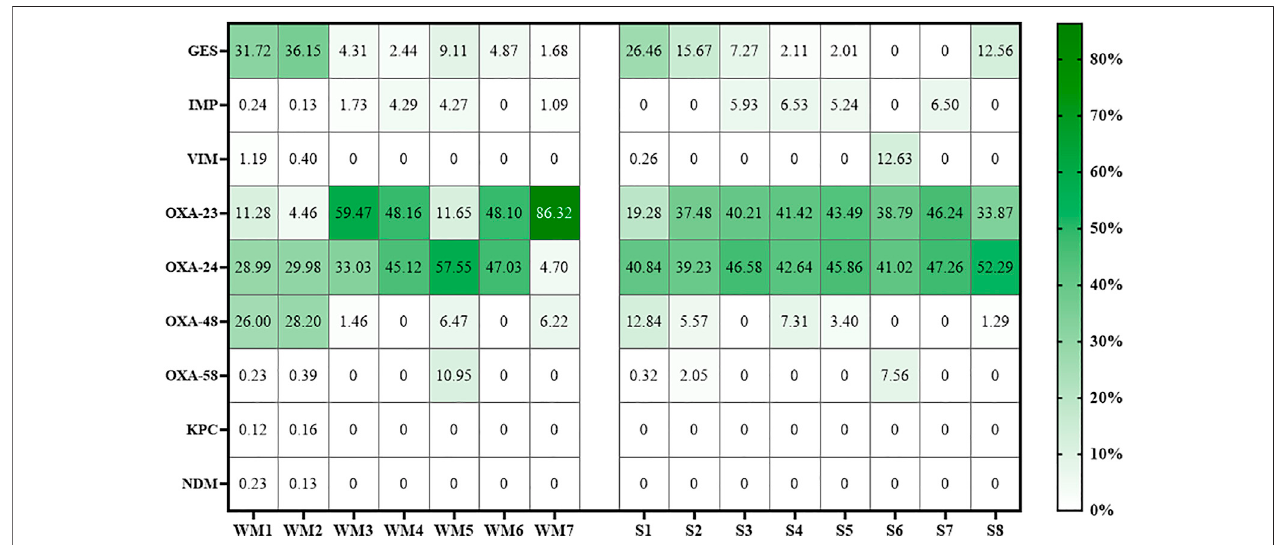
FIGURE1| PercentagedistributionofcarbapenemasegenesinsamplesfrombothWWTPs.Abbreviations:WM,wastewatertreatmentplantfromtheWarmiaand Mazury region; S, wastewater treatment plant from the Silesia